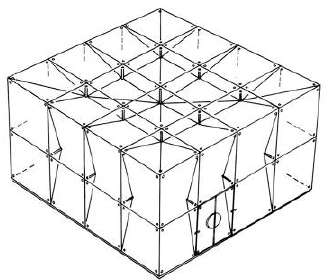
Figure 4: Flower shop on the famous Lijnbaan in